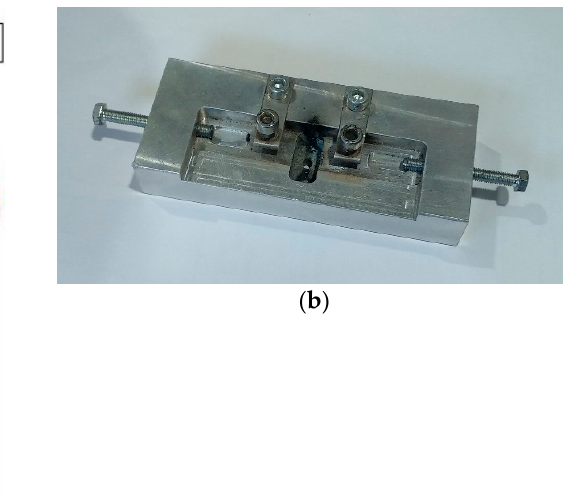
Figure 2. Illustration of the support/fixation system operation.